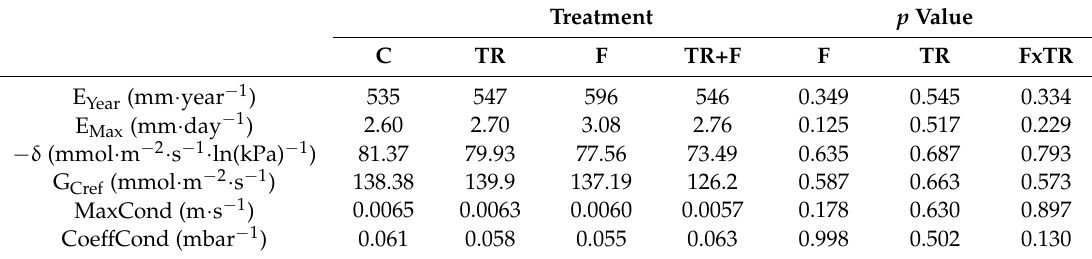
Table 3. Water use and stomatal sensitivity to vapor pressure deficit reported as mean annual transpiration (E Year ), maximum daily transpiration (E Max ), sensitivity of stomatal conductance to vapor pressure deficit (- δ ), stomatal conductance at vapor pressure deficit = 1 kPa (G Cref ), 3-PG